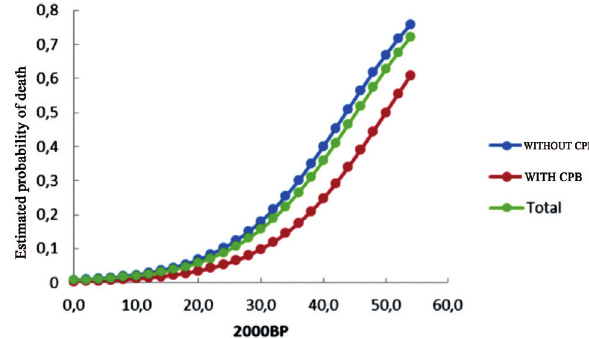
Fig. 6 - Model for logistic EuroSCORE (EU) showing the probability of death overall, and for each of the groups with and without cardiopulmonary bypass for patients undergoing coronary artery bypass